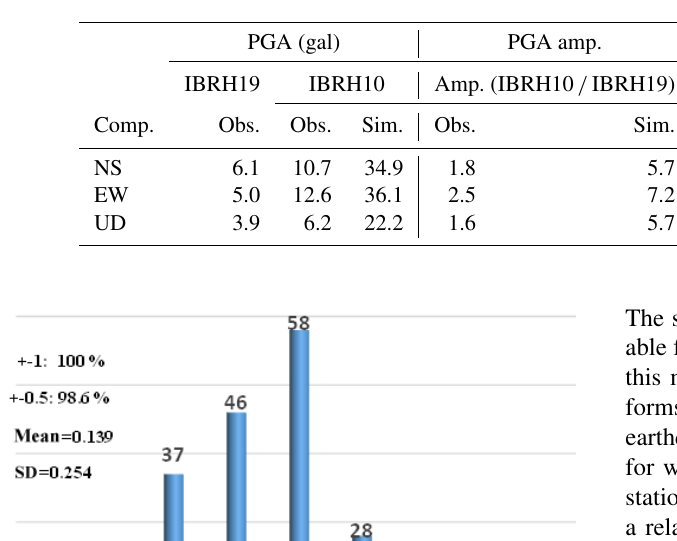
Table 5. Information for M 5 . 3 earthquake (IBRH10 and IBRH19 for 201103162239).